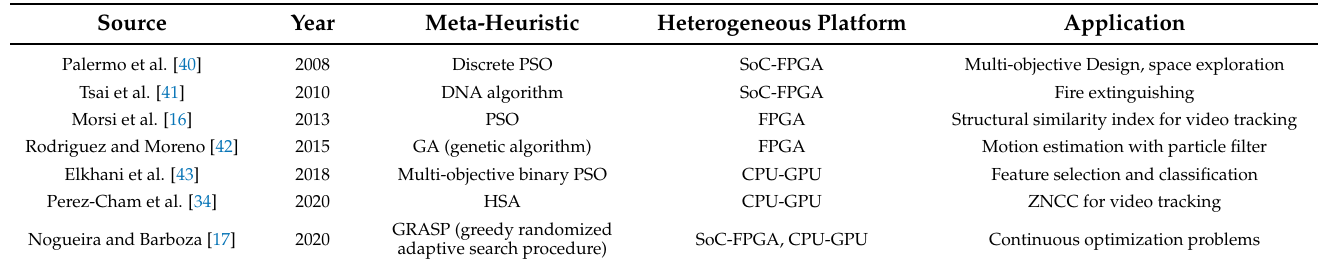
Table 1. Brief summary of the related work which focuses on other publications that deal with heterogeneous computing systems and